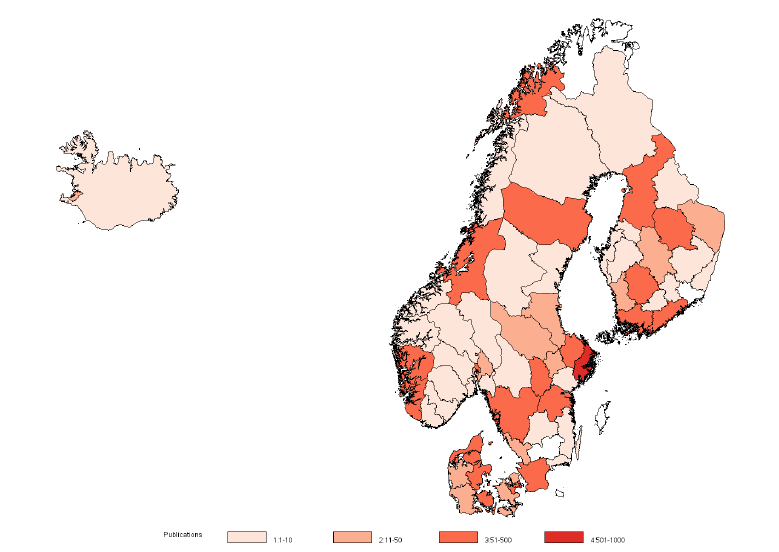
Figure A.3: Publication Output for Cardiovascluar Medical Devices at Regional levels of NUTS-3 in Europe: Iceland, Finland, Denmark, Sweden, Norway